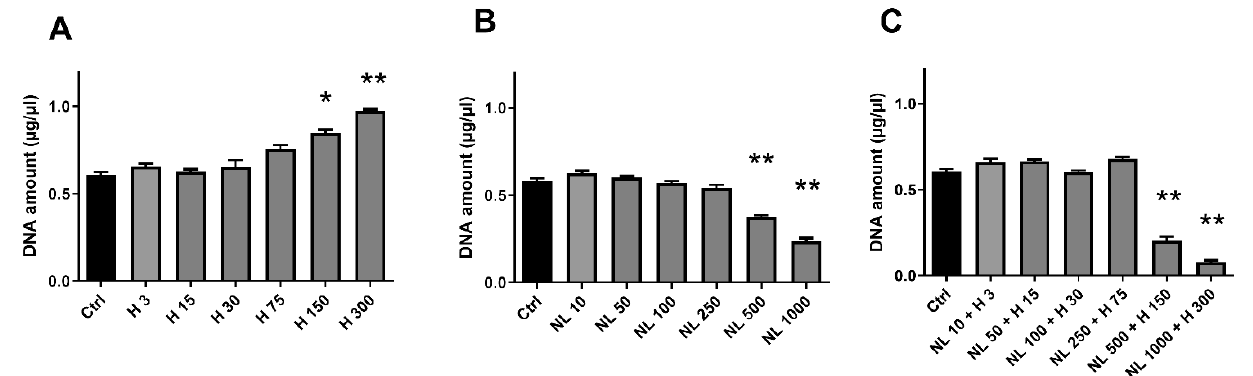
Figure 5. Evaluation of cell proliferation with increasing concentrations of hop extract, empty nanoliposomes, and nanoliposomes encapsulating hop extract in chondrocytes. Human chondro- cytes were exposed in vitro to increasing concentrations of ( A ) hop extract alone (3 to 300 µg/mL),